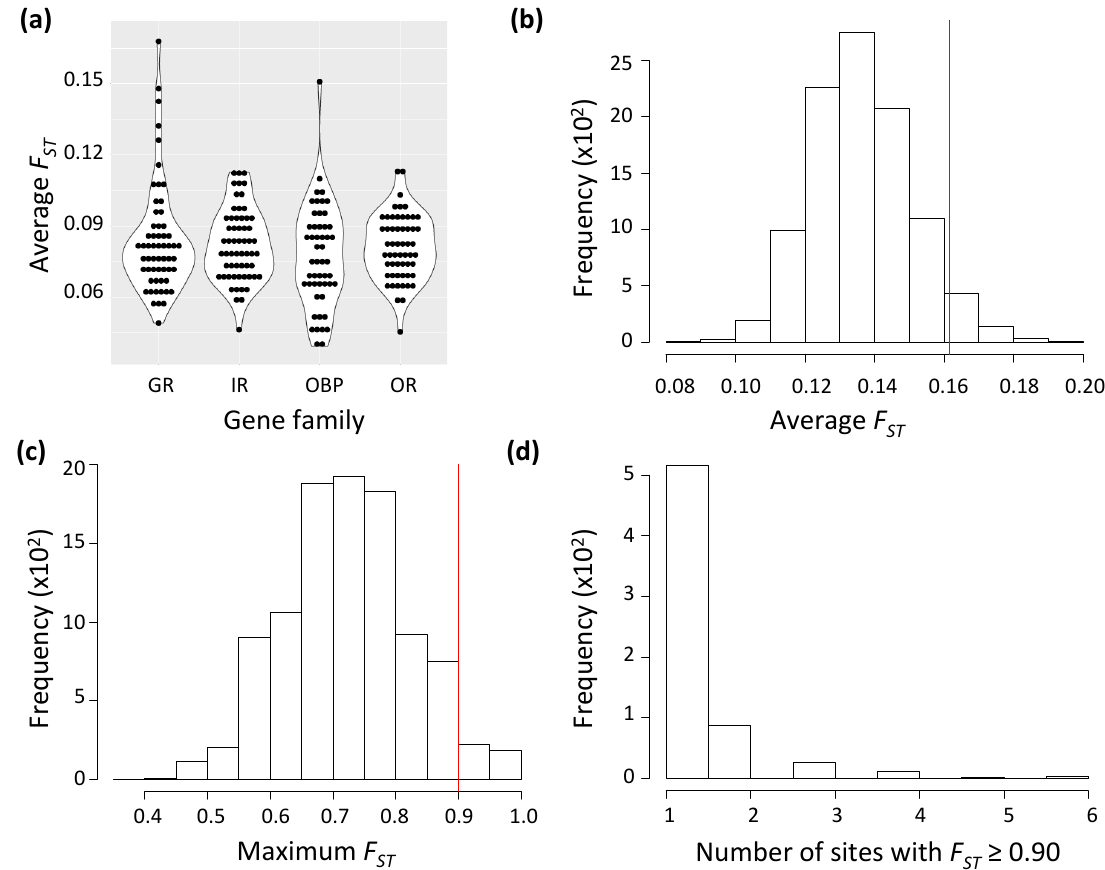
Figure 1. ( a ) Kernel density distributions of genetic differentiation ( F ST ) estimates at chemosensory genes ( ± 2 kb) between specialist Drosophila yakuba mayottensis from Mayotte and generalist D. y. yakuba from Kenya. Gene families are abbreviated as: GR = gustatory receptors, IR = ionotropic receptors, OBP = odorant-binding-proteins and OR = olfactory receptors. ( b–d ) Histograms of the outcome of the msms simulations based on DADI-inferred demographic model based on pre- sumably neutral autosomal short intronic sequences for ( b ) average F ST , ( c ) maximum F ST , and ( d ) number of sites with F ST ≥ 0.9 per run. Vertical red lines indicate the 0.95 quantile F ST